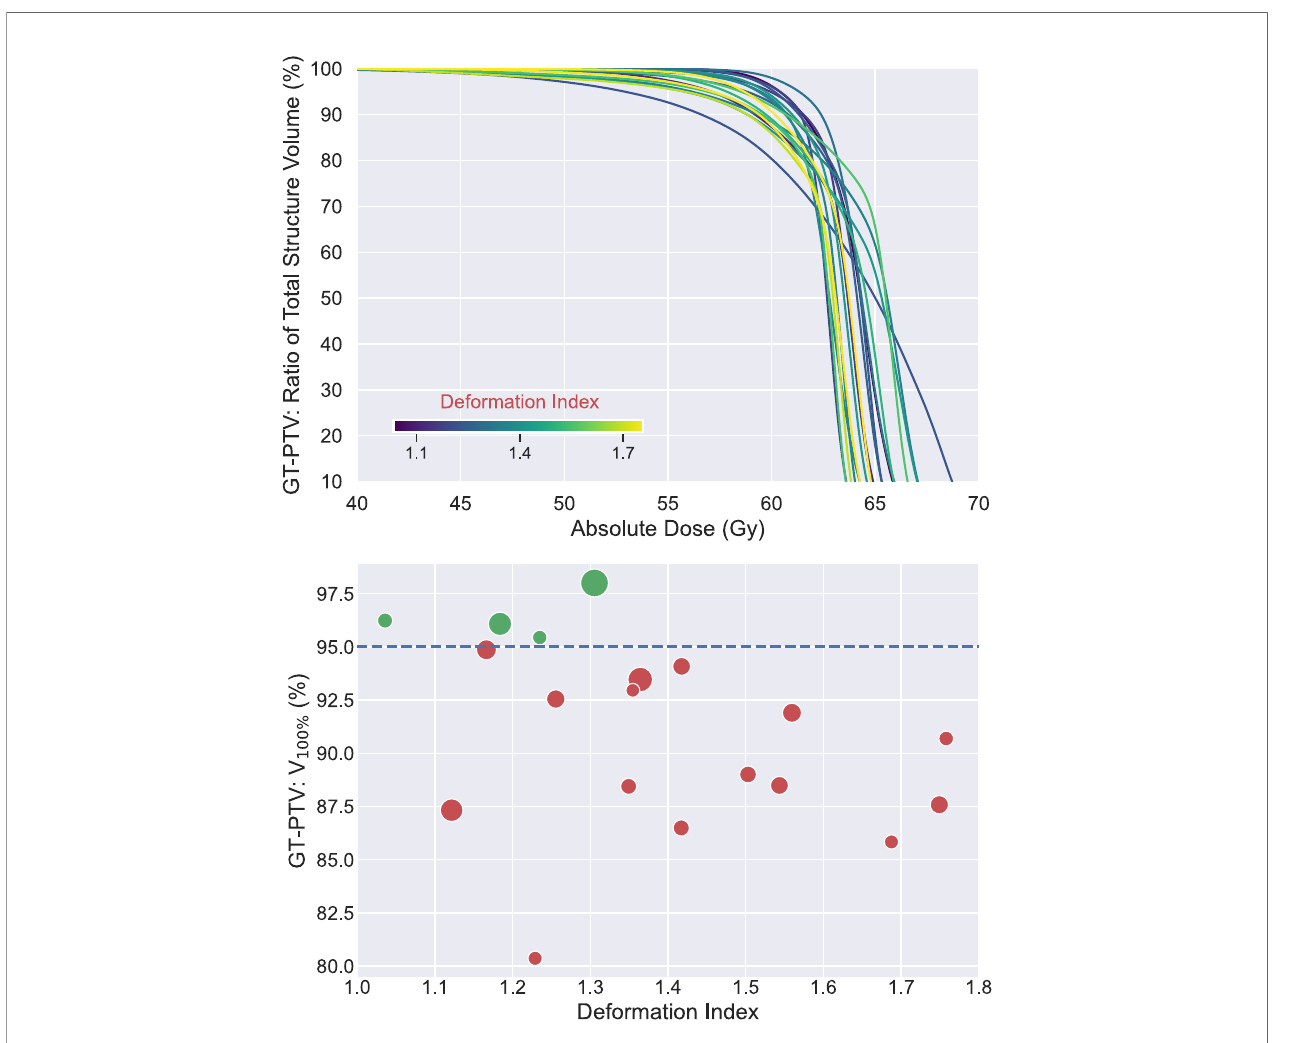
FIGURE 7 | Top: dose volume histograms (n = 19) of ground-truth planning target volumes (GT-PTVs) created with volumetric modulated arc therapy (VMAT) plan targeting corresponding auto-propagated planning tumor volume (AP-PTV). All plans met dose prescription of V 100% ≥ 95% of AP-IGTV and nearby organ at risk (OAR) constraints. Each line colored according to auto-propagated internal gross target volume (AP-IGTV) deformation index. Bottom: scatter plot of V 100% values of GT-PTVs as a function of deformation index of the corresponding AP-IGTV. Dots in green above the blue dashed line met planning objective of V 100% ≥ 95%, whereas dots in red below the blue dashed line failed to meet the constraint. Size of the dots is proportional to the size of ground-truth internal gross target volume